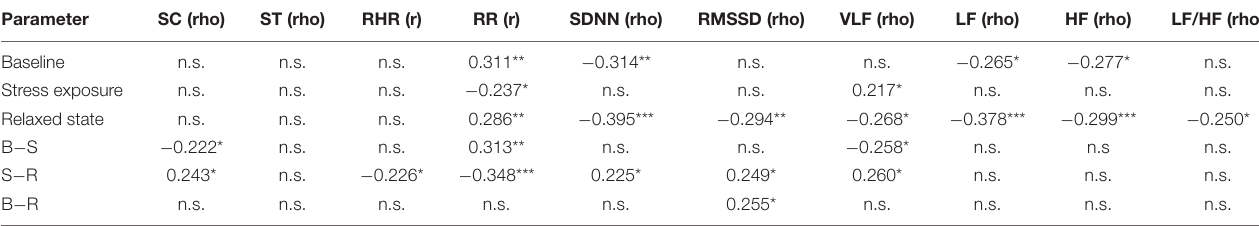
TABLE 4 | Systolic blood pressure and electrophysiological parameters. Parameter SC (rho) ST (rho) RHR (r) RR (r) SDNN (rho) RMSSD (rho) VLF (rho) LF (rho) HF (rho) LF/HF (rho) Baseline n.s. Stress exposure Relaxed state